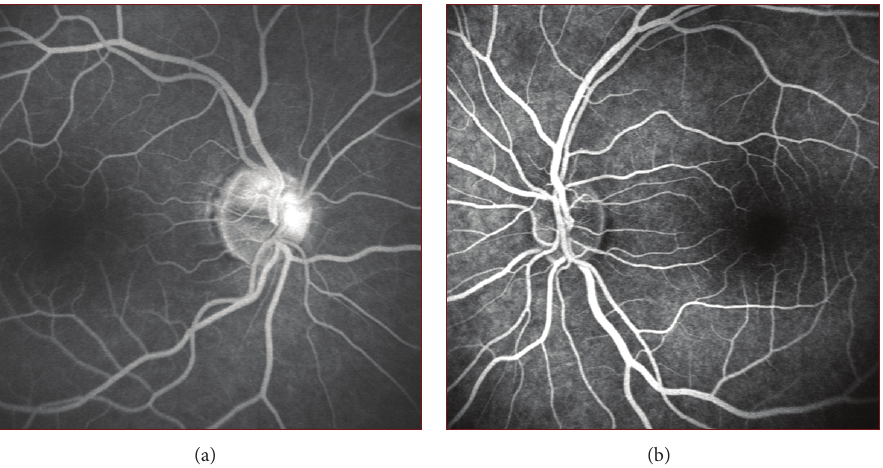
Figure 1: (a) FA images of a patient showing optic disc hyperfluorescence and (b) a normal FA image of another